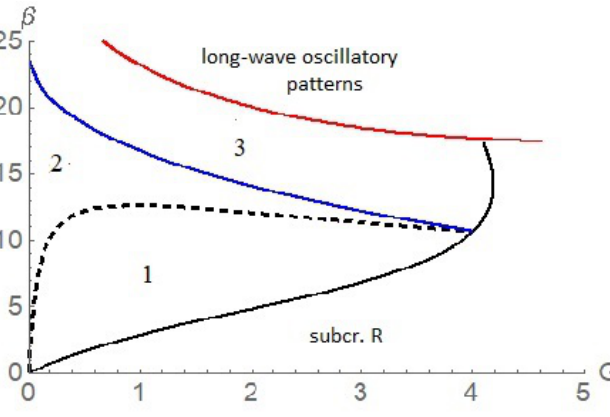
Figure 5. Stability map of the stationary rolls in the case without